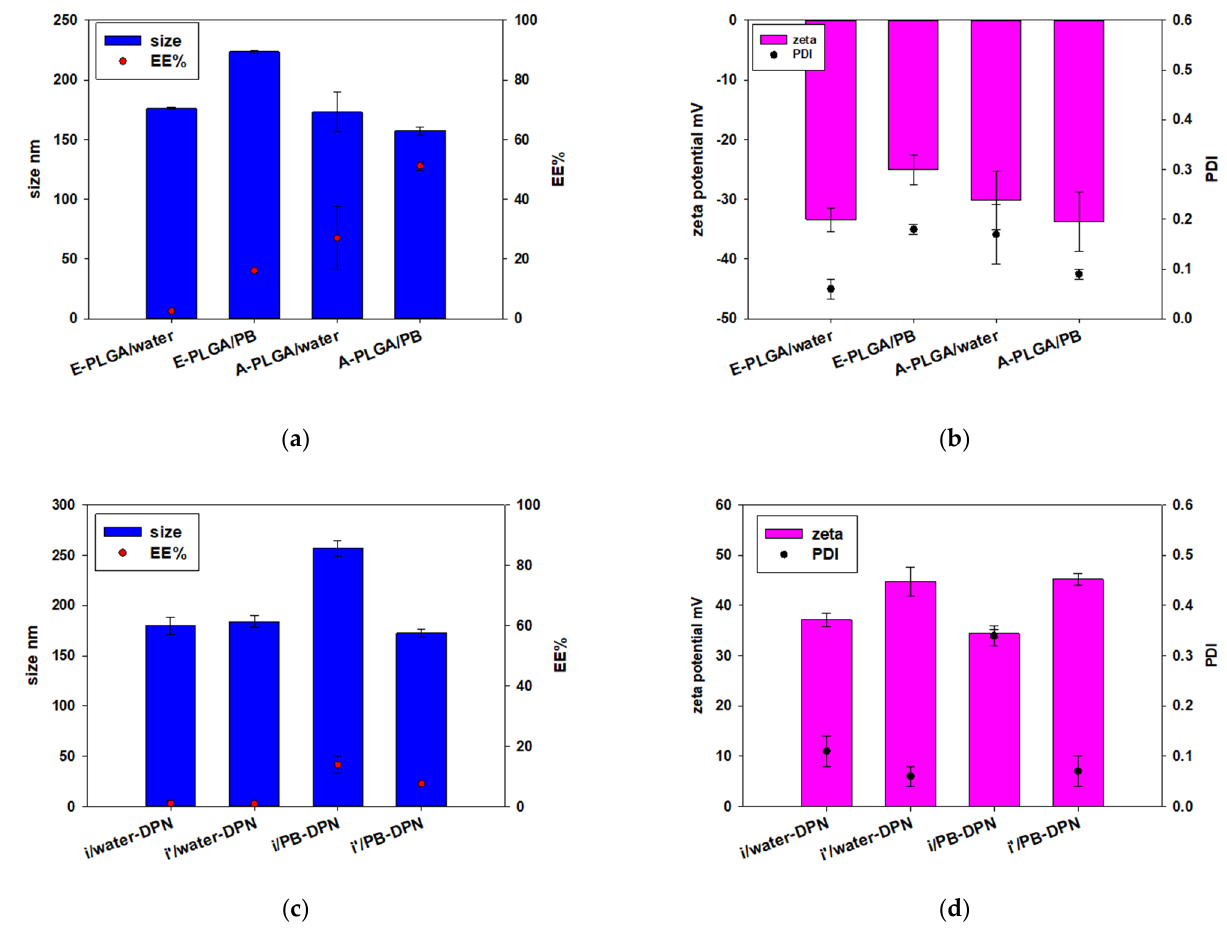
Figure 2. The effect of different types of PLGA and W2 on ( a ) diameter and EE% (encapsulated efficiency percentage) ( b ) zeta potential and PDI (polydispersity index) of DPN, and the effect of incorporated PEI and W2 on ( c ) diameter and EE% ( d ) zeta potential and PDI of iDPN and i’DPN. (n = 3; mean ± standard deviation). E-PLGA/water (E-PLGA was dissolved in O and W2 was water), E-PLGA/PB (E-PLGA was dissolved in O and W2 was PB), A-PLGA/water (A-PLGA was dissolved in O and W2 was water), A-PLGA/PB (A-PLGA was dissolved in O and W2 was PB), i/water-DPN (PEI was added in W1 during the incorporation process and W2 was water), i’/water-DPN (PEI was added in O during the incorporation process and W2 was water), i/PB-DPN (PEI was added in W1 during the incorporation process and W2 was PB), i’/PB-